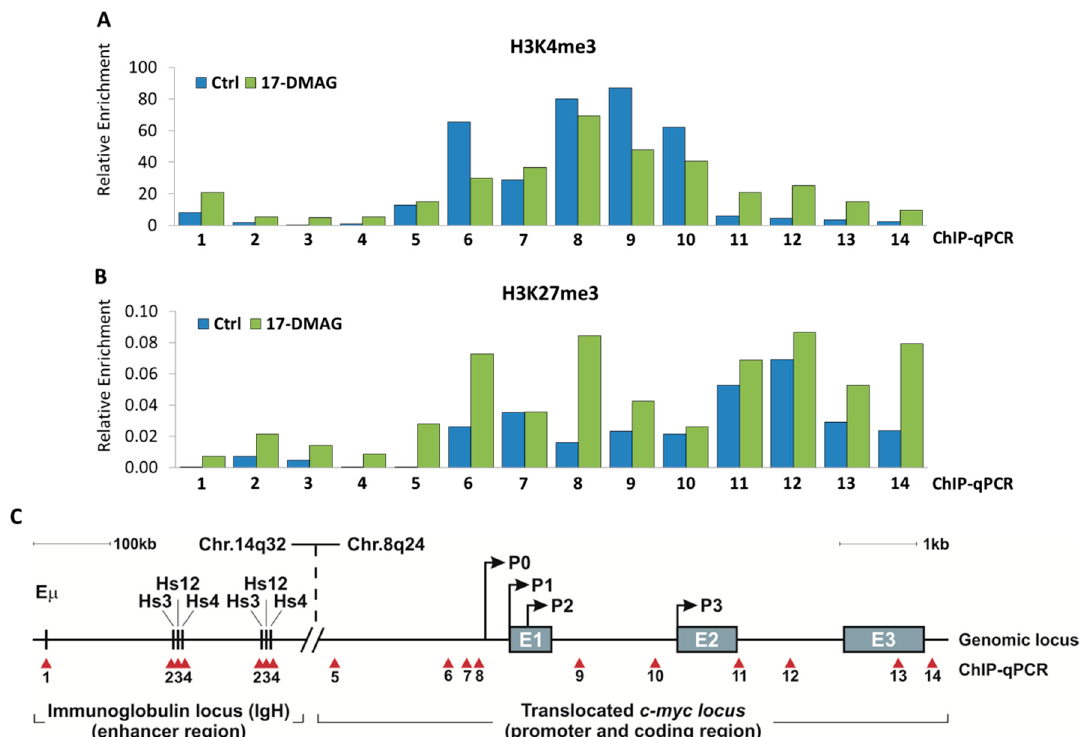
Figure 5. 17-DMAG treatment alters chromatin status at the translocated MYC locus in Burkitt lymphoma. ChIP-qPCR for ( A ) H3K4me3 modifications and ( B ) H3K27me3 modifications at the MYC locus upon 1 µM 17-DMAG treatment for three days. ( C ) Visual schematic of ChIP-qPCR tiling amplicons in the immunoglobulin enhancers: Eµ , Hs3 , Hs12 , and Hs4 (#1–4) of chromosome 14, and in the translocated MYC promoter (#5–10) and the MYC locus (#11–14) of chromosome 8. Red arrows indicate placement of amplicon. MYC promoters are referred to as “P”, and Exons as “E”. ChIP-qPCR was normalized to Input DNA. Each bar is representative for average mean of duplicate samples.